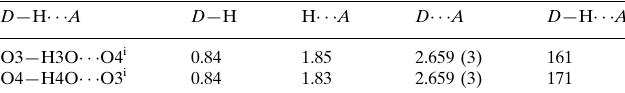
Hydrogen-bond geometry (A˚ , (cid:2)